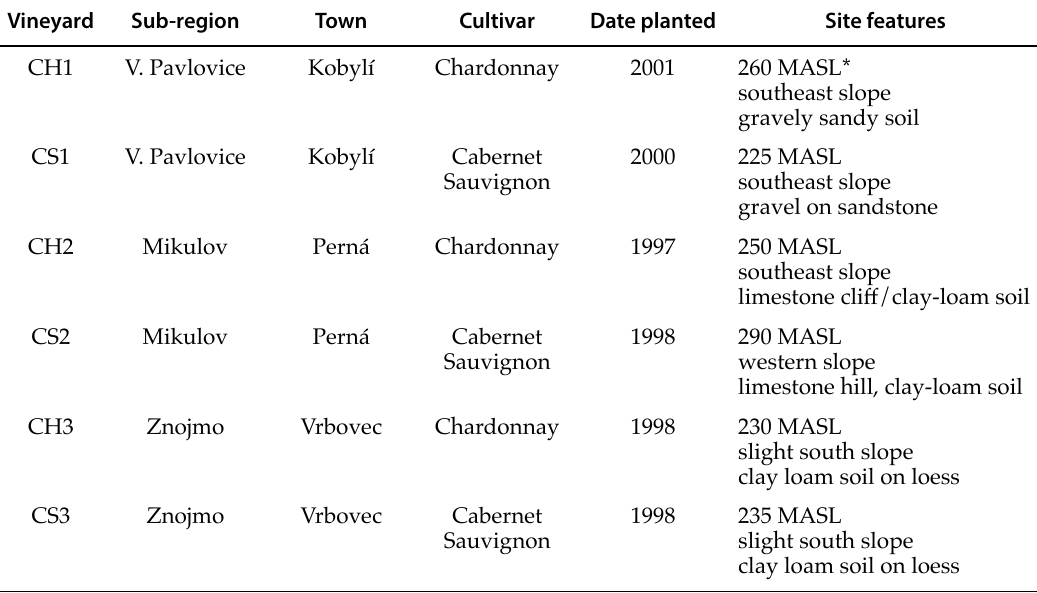
Table 1. Details of vineyards surveyed for grapevine trunk diseases in the Czech Republic.